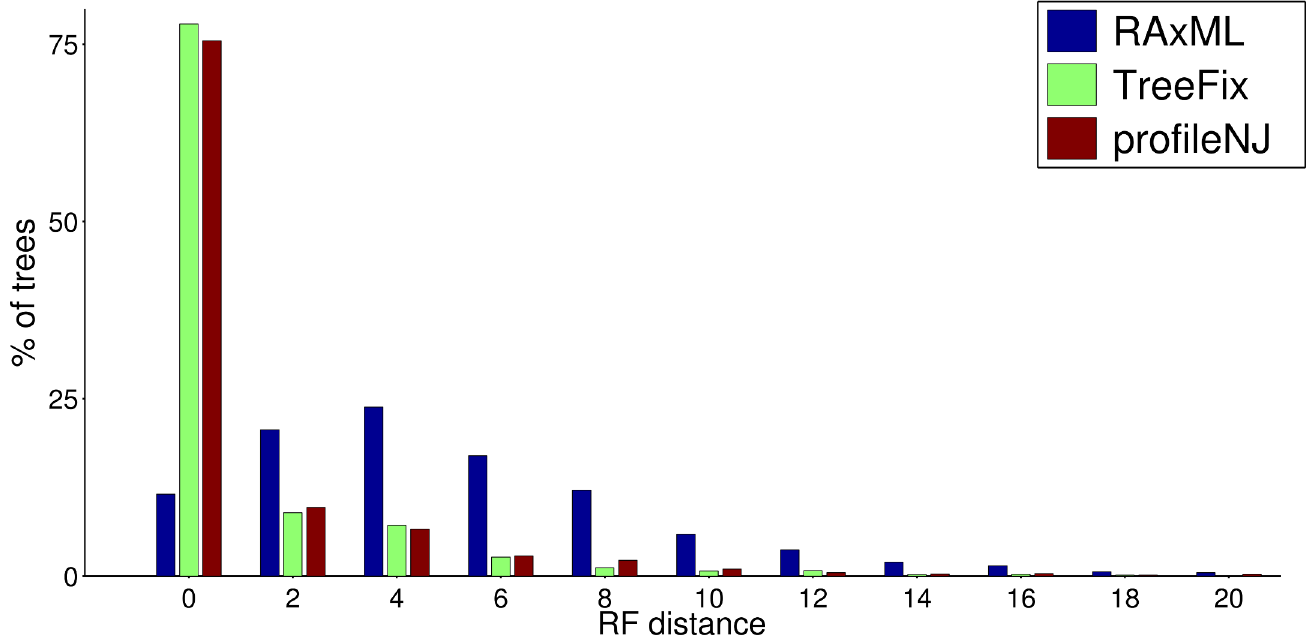
Fig 2. Topology accuracy of RAxML, TreeFix and ProfileNJ trees, measured by RF distance with the true tree, on * 2500 simulated trees from the fungal dataset. We use a sample of trees simulated under four different DL rate: (1 r D — 1 r L ), (2 r D — 2 r L ), (4 r D — 4 r L ) and (4 r D — 1 r L ). Percentage of reconstructed trees (y-axis) with a given RF distance (x-axis) to the true tree. TreeFix and ProfileNJ have a similar reconstruction accuracy (75% of trees match the true trees) while the input trees (RAxML) have the lowest accuracy. The graph is cut on the right, but contains more than 99% of the